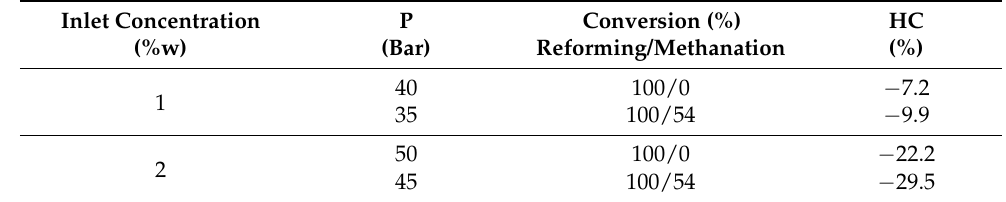
Table 3. Maximum HC values for different concentrations of wastewater inlet.